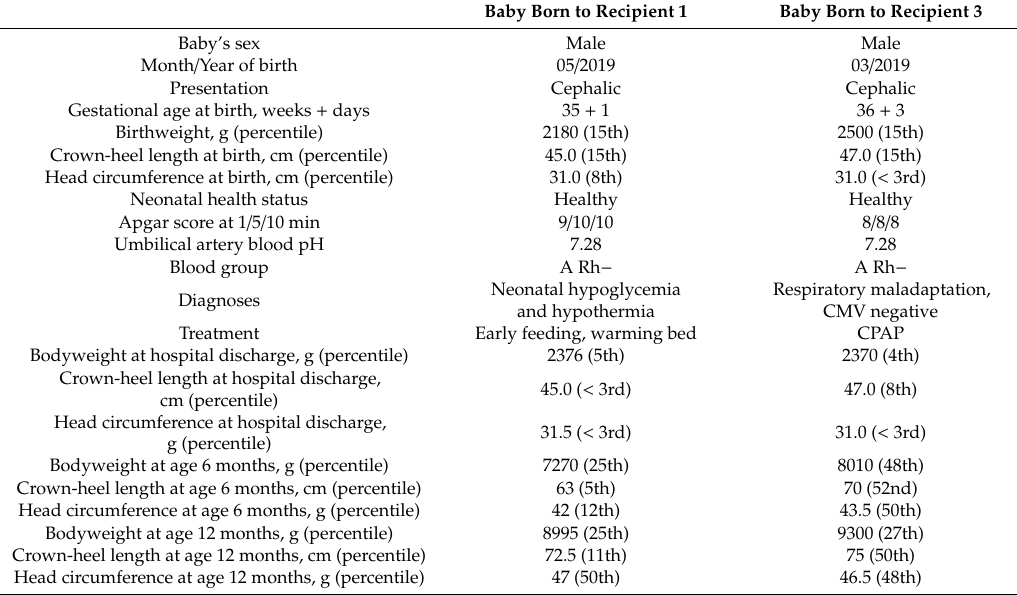
Table 3. Clinical characteristics of two newborns from two women with transplanted